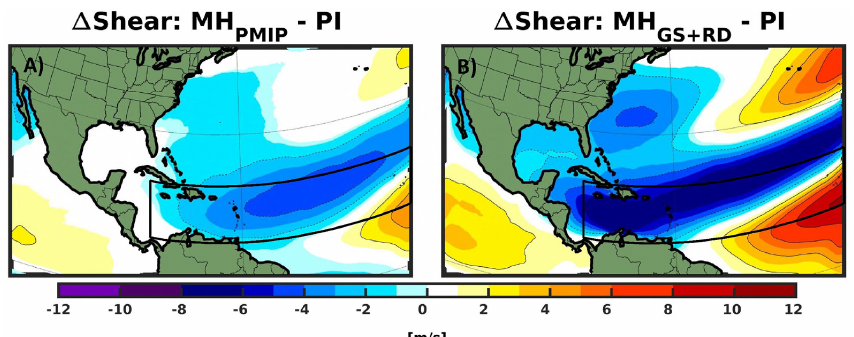
Figure A7. Changes in vertical wind shear (300–850hPa) for the (a) MH PMIP and (b) MH GS + RD experiments relative to PI. The black box shows the approximate present-day MDR. Only values that are significantly different at the 5% level using a local (grid-point) t test are shaded. The contour lines follow the color-bar scale (dashed, negative anomalies; solid, positive anomalies); the 0 line is omitted for clarity.